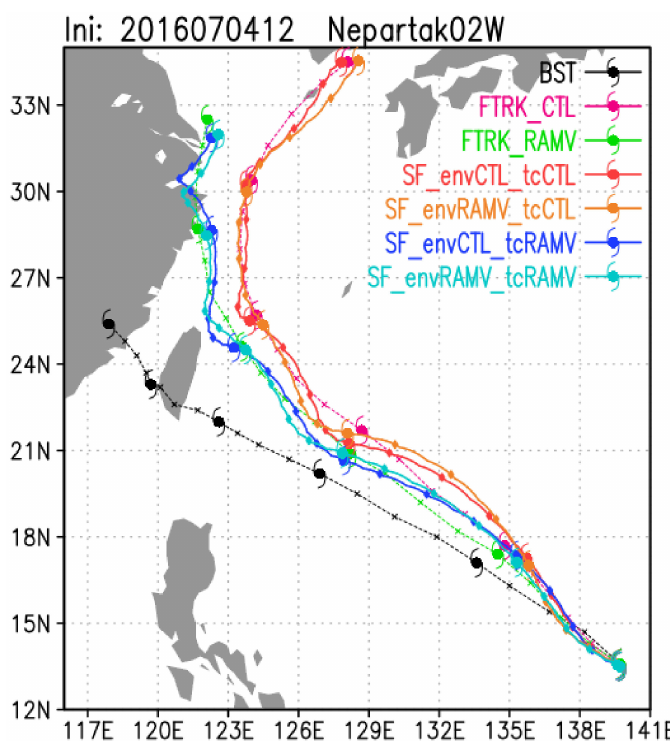
Figure 7. Forecasted track for Nepartak initialized at 1200 UTC 4 July 2016. BST is the best track. FTRK_CTL and FTRK_RAMV are the forecasted track by CTL and RAMV. SF indicates the trajectory calculated from the steering flows. envCTL and envRAMV represent the environmental flows by CTL and RAMV, respectively. tcCTL and tcRAMV represent the TC-induced flows by CTL and RAMV, respectively. TC symbols are plotted with a 24-h